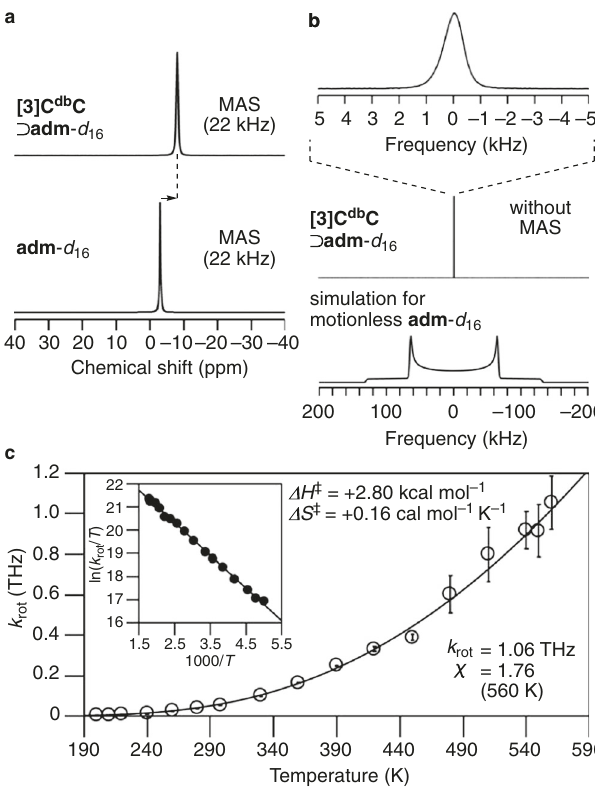
Fig. 5 Ultrafast solid-state rotations of a diamondoid molecule in the hybrid nanocarbon peapod of adm ⊃ [3]C db C from 2 H NMR analyses. a A high- fi eld shift observed between the spectra of [3]C db C ⊃ adm - d 16 and free adm - d 16 under MAS conditions (298 K). b A symmetric narrow peak of adm - d 16 observed with [3]C db C ⊃ adm - d 16 under static conditions without MAS (298 K). A hypothetical spectrum simulated for motionless adm - d 16 is shown at the bottom as a reference to show its absence. c Temperature- dependent rotational frequency ( k rot ) recorded with [3]C db C ⊃ adm - d 16 . The bars show the standard errors of the